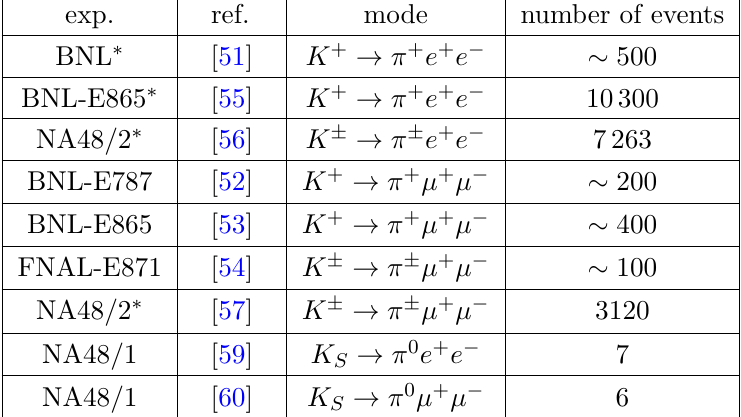
Table 1 . Experimental situation concerning the decay modes K (cid:6) The experiments marked with an asterisk also provide information on the decay